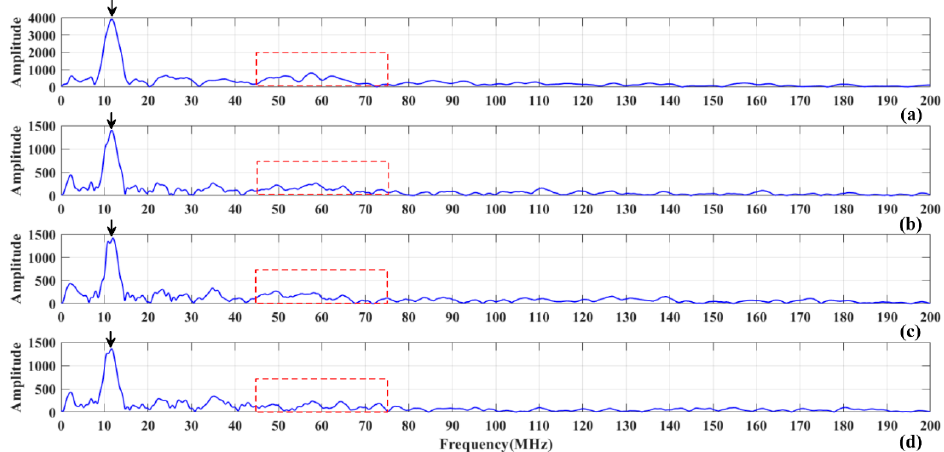
Figure 4. Frequency spectrum of traces. ( a ) N104. ( b ) N106. ( c ) N202. ( d ) N206. Appl. Sci. 2020 , 10 , x FOR PEER REVIEW